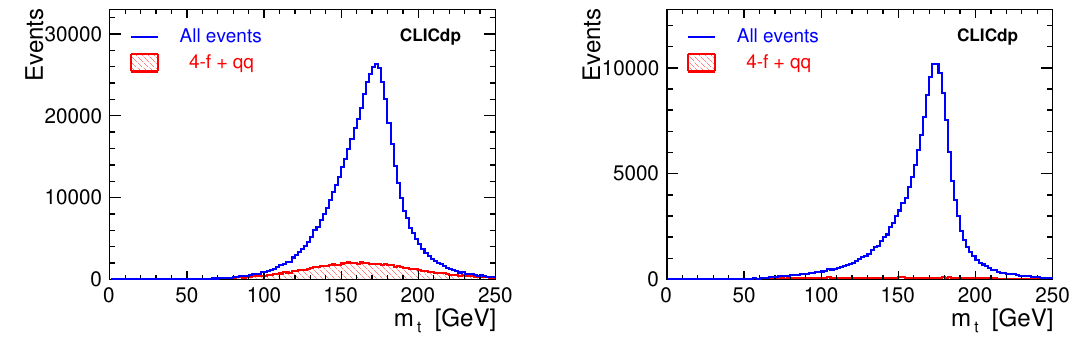
Figure 15. Distributions of the top-quark mass reconstructed from the hadronic top-quark decays for hadronic (left) and semi-leptonic (right) events, for 1 : 0 ab (cid:0) 1 at 380 GeV